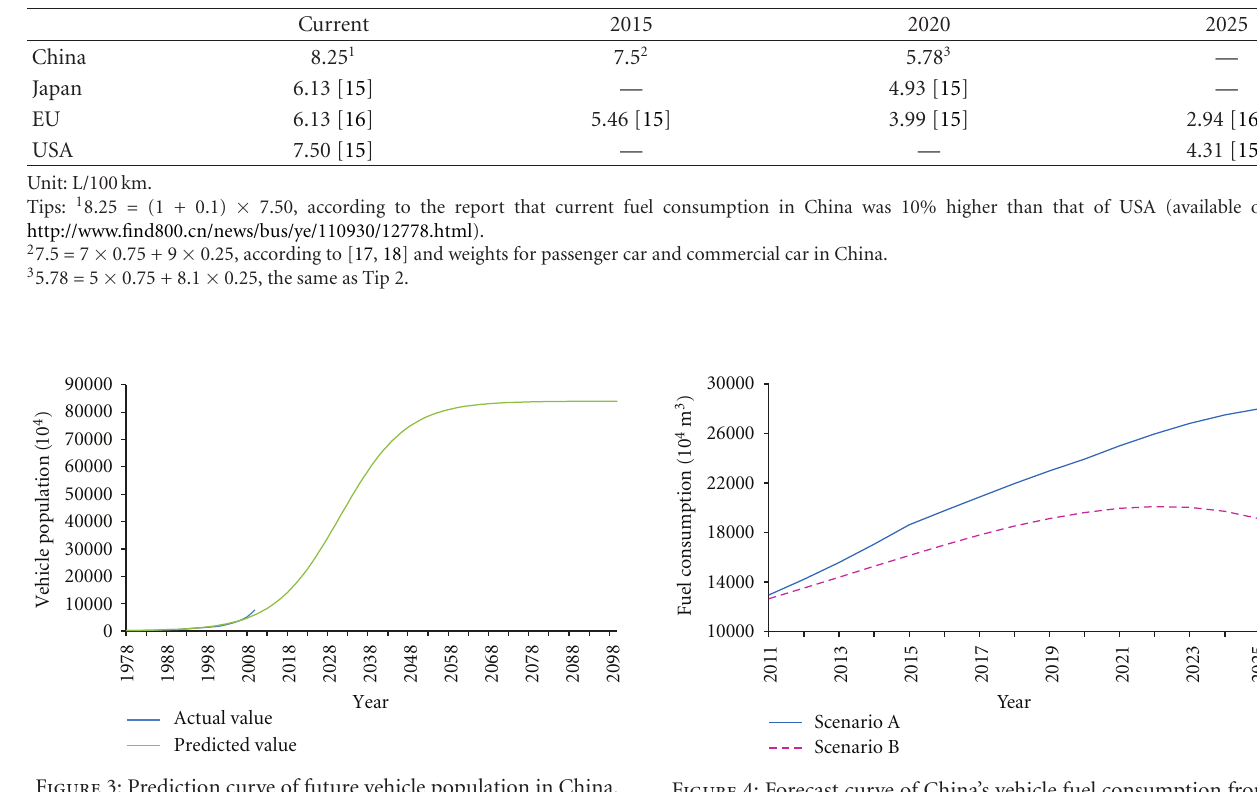
Table 3: Statuses and planning targets of domestic and foreign vehicle average fuel consumption per hundred kilometers per car.